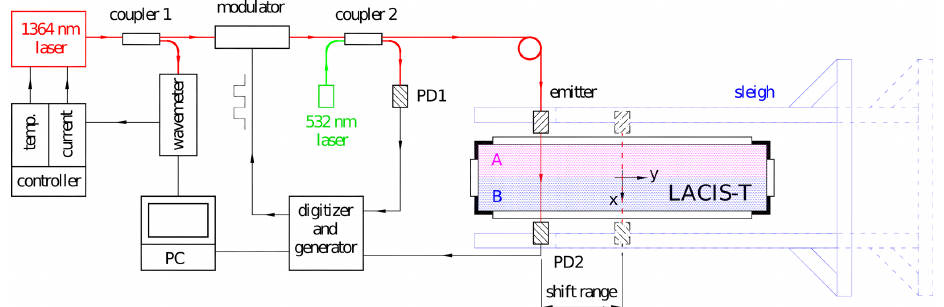
Figure 3. Schematic of the FIRH implementation at LACIS-T. The emitter and the photodetector PD2 are mounted on the movable sleigh, which allows for the convenient scanning of the measurement volume at both transverse orientations: across the short (as marked in this scheme) and long (perpendicular to what is depicted in this scheme) dimensions of the measurement section of the wind tunnel.